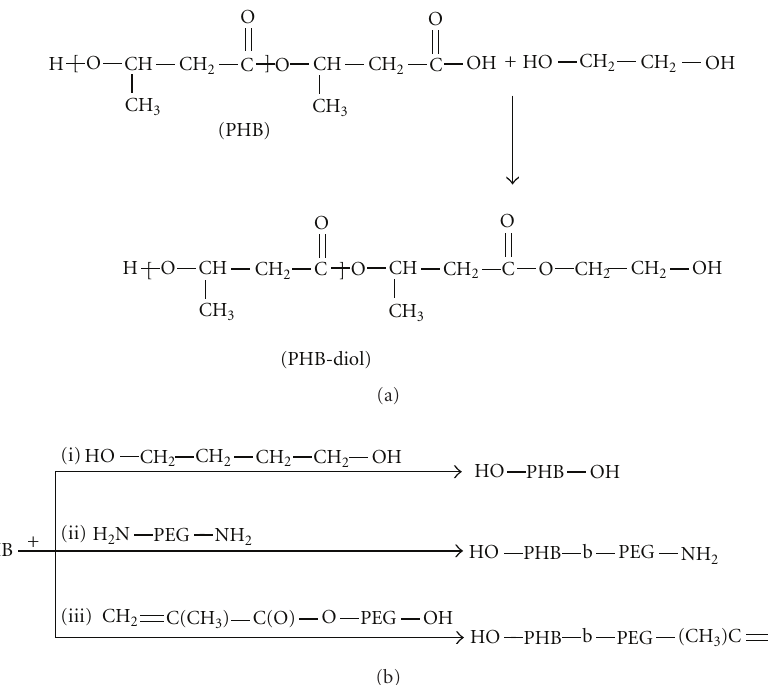
Figure 1: (a) Formation of the diol ended PHB via transesterification in the presence of ethylene glycol. (b) Transesterification reactions of PHB with (i) butane diol, (ii) transamidation with bisaminopropyl ended PEG, and (iii) transesterification reactions of PHB with methacryloyl oxy ethylene glycol in